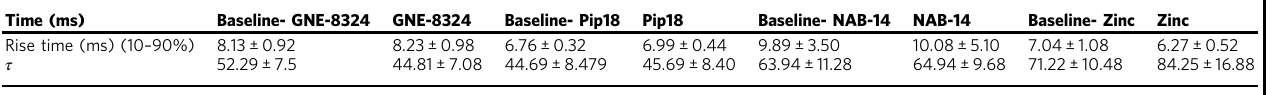
Table 1 Characterization of NMDAR EPSCs in the inhibitory neurons under various conditions Time